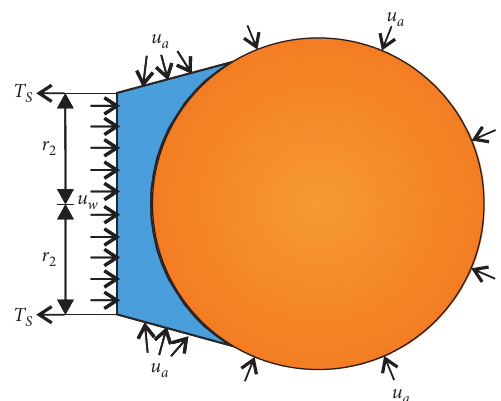
Figure 8: Free-body diagram of inter-particle